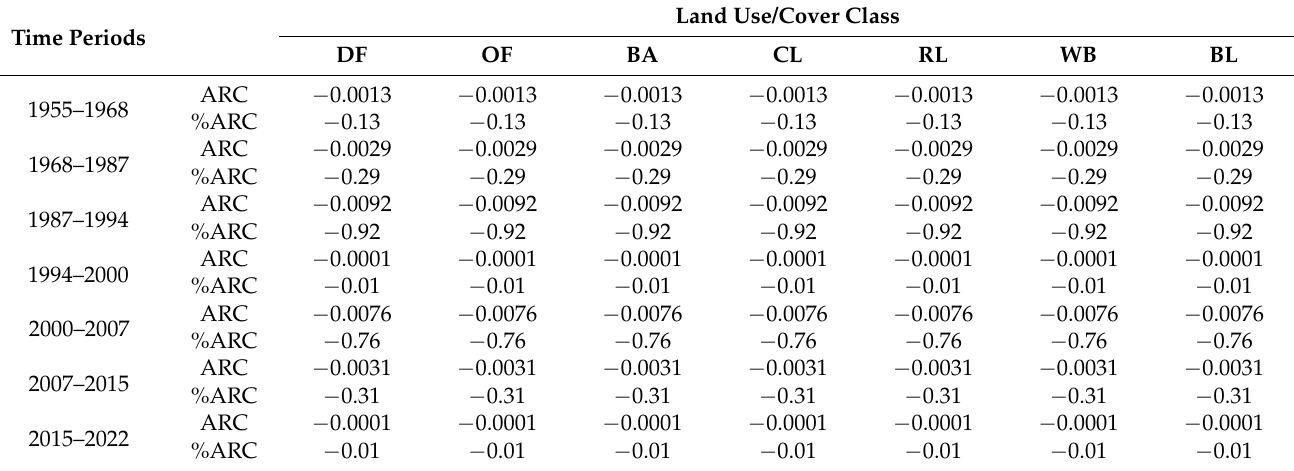
Table 7. Annual rate of change (ARC) and its percent in different land use/cover types during the studied time periods.